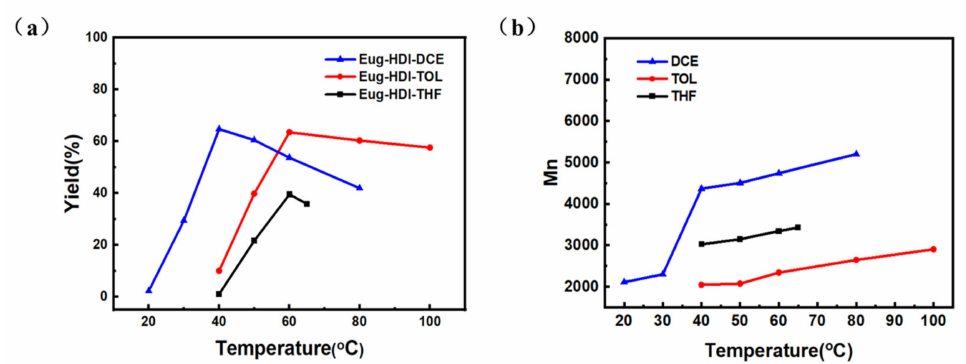
Figure 1. ( a ) Yield-temperature graph of Eug-HDI polymerization in different solvents, and ( b ) num- ber average molecular weight-temperature graph of Eug-HDI polymerization in different